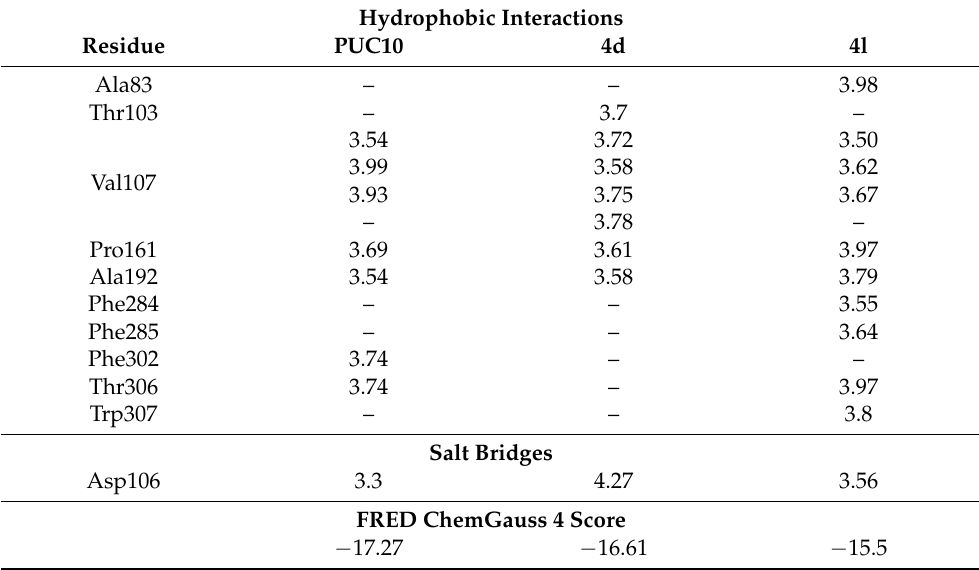
Table 2. Docking scoring and distance (in Å) of hydrophobic and salt bridge interactions established with residues within the binding site and compounds PUC10 , 4d and 4l .